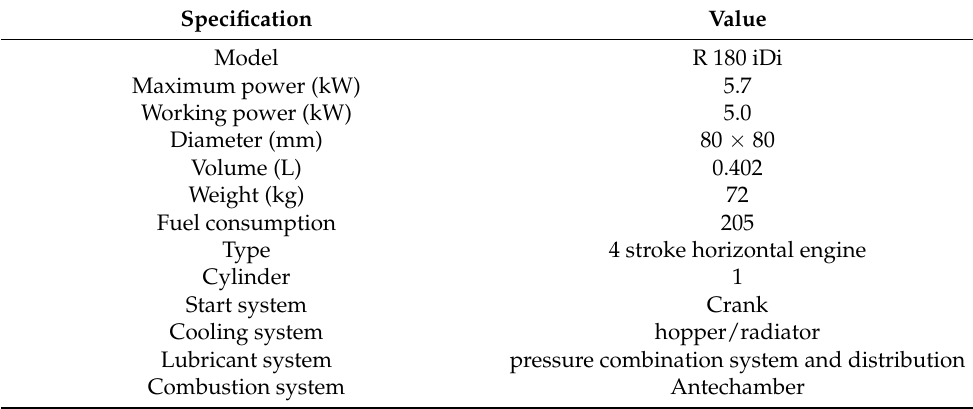
Table 3. Diesel engine specification.